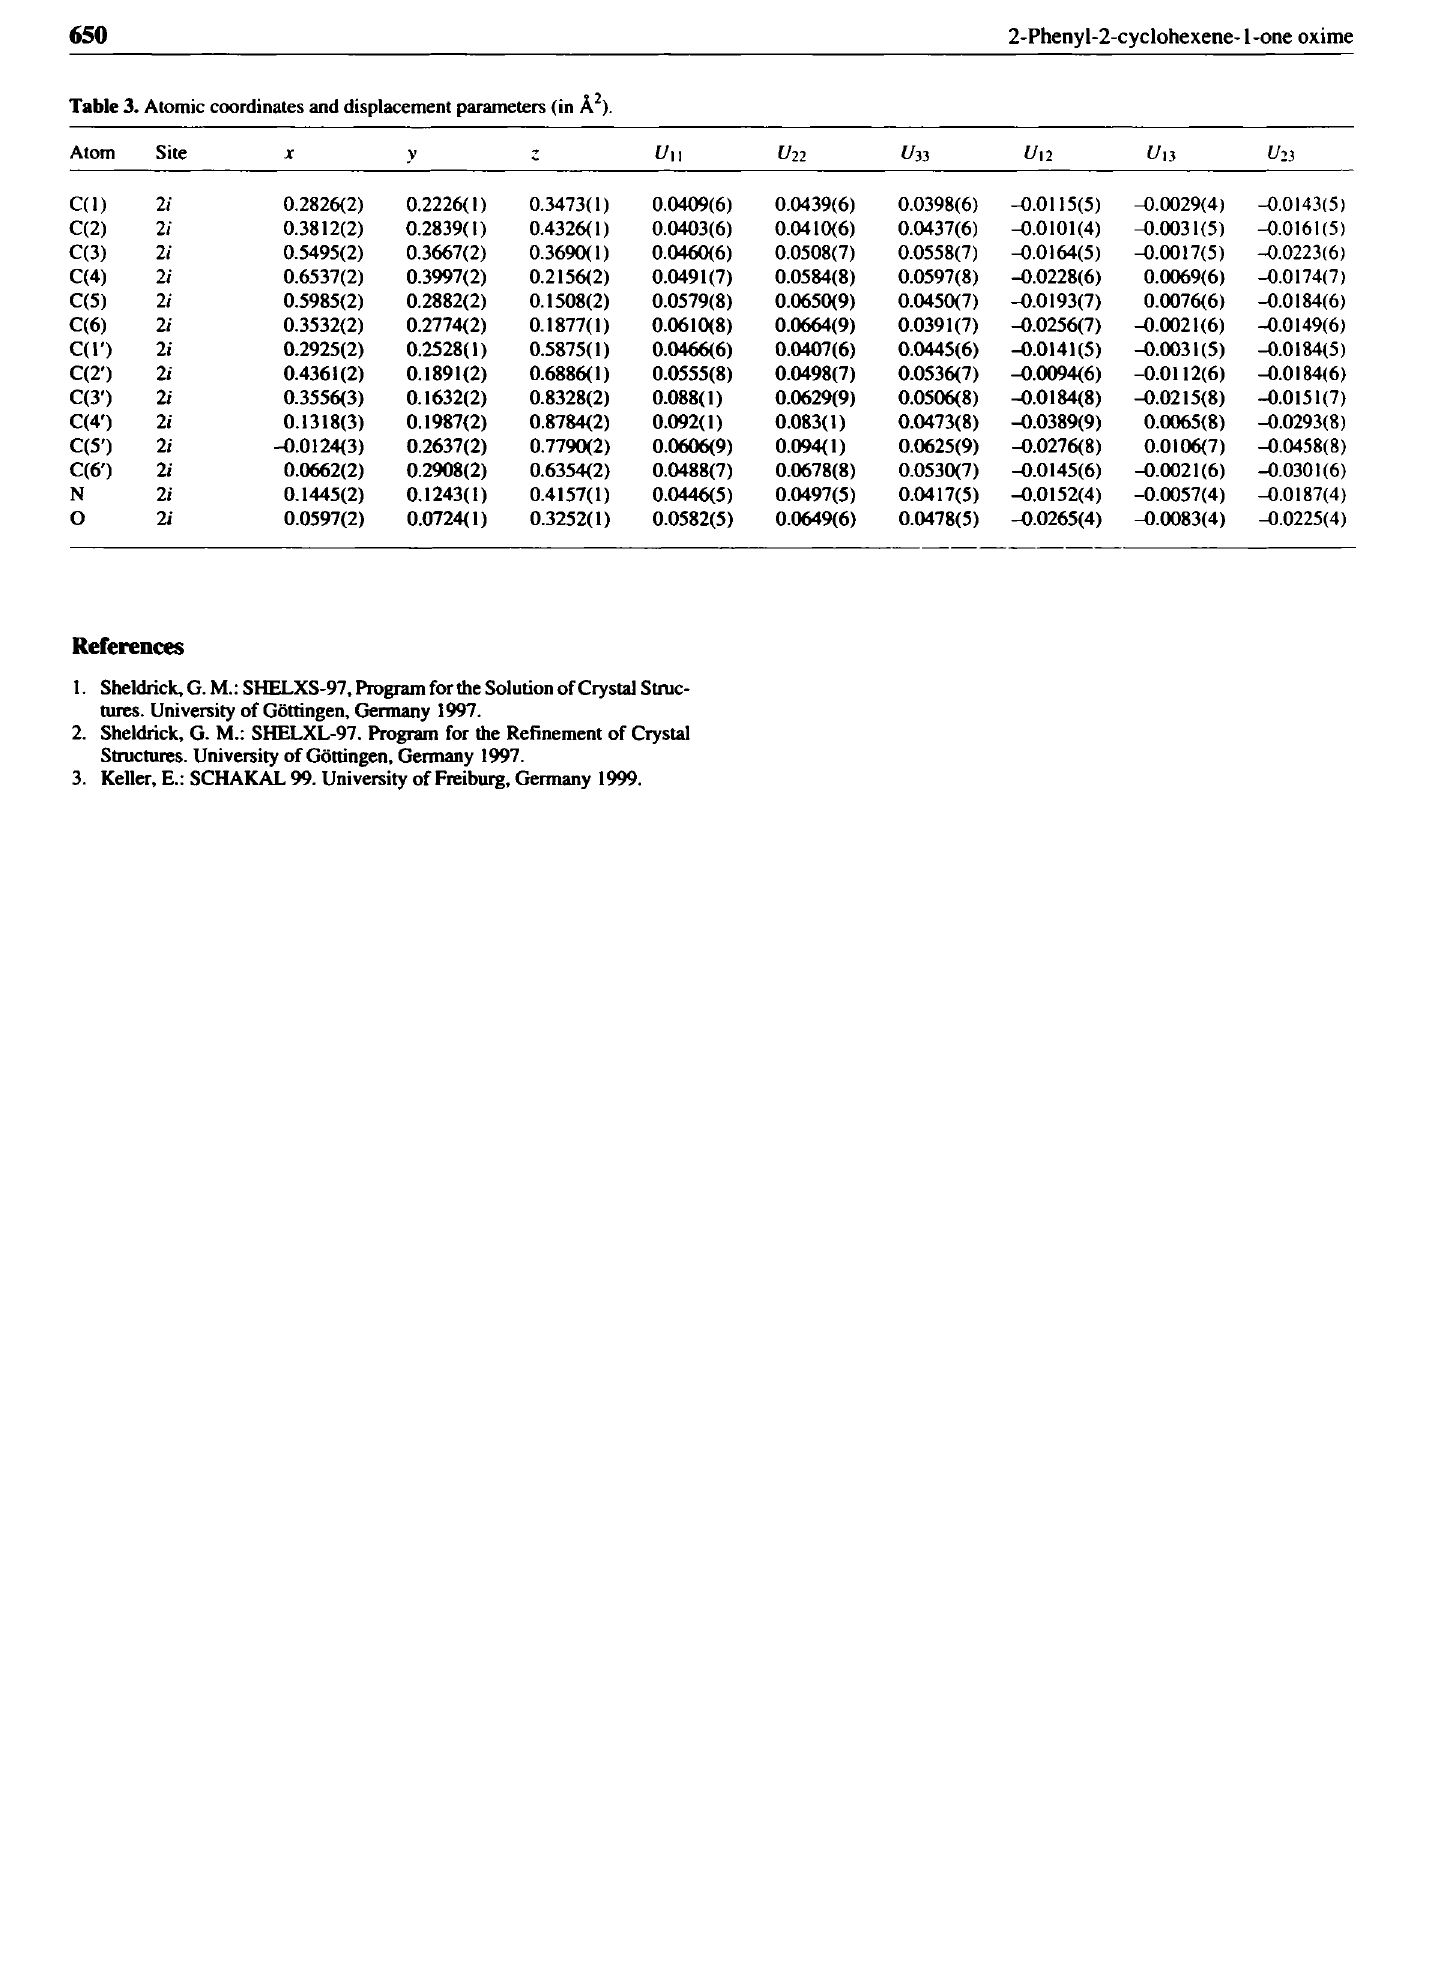
Table 3. Atomic coordinates and displacement parameters (in A 2